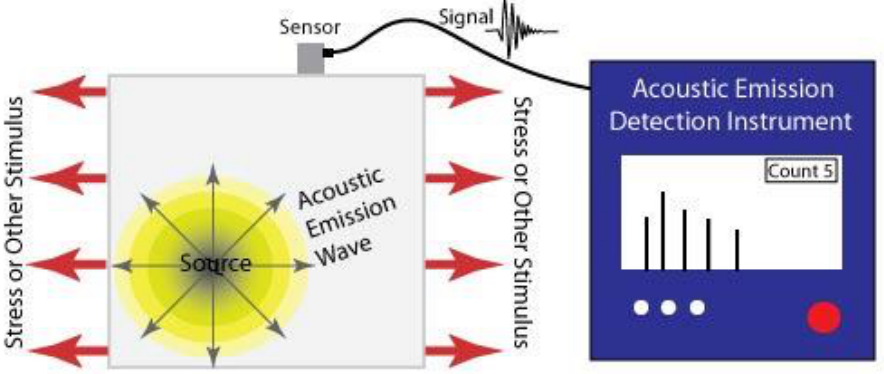
Figure 2. Acoustic emission detection. Reprinted by permission from, ©Iowa State University Center for Nondestructive Evaluation (CNDE) ref. [26].